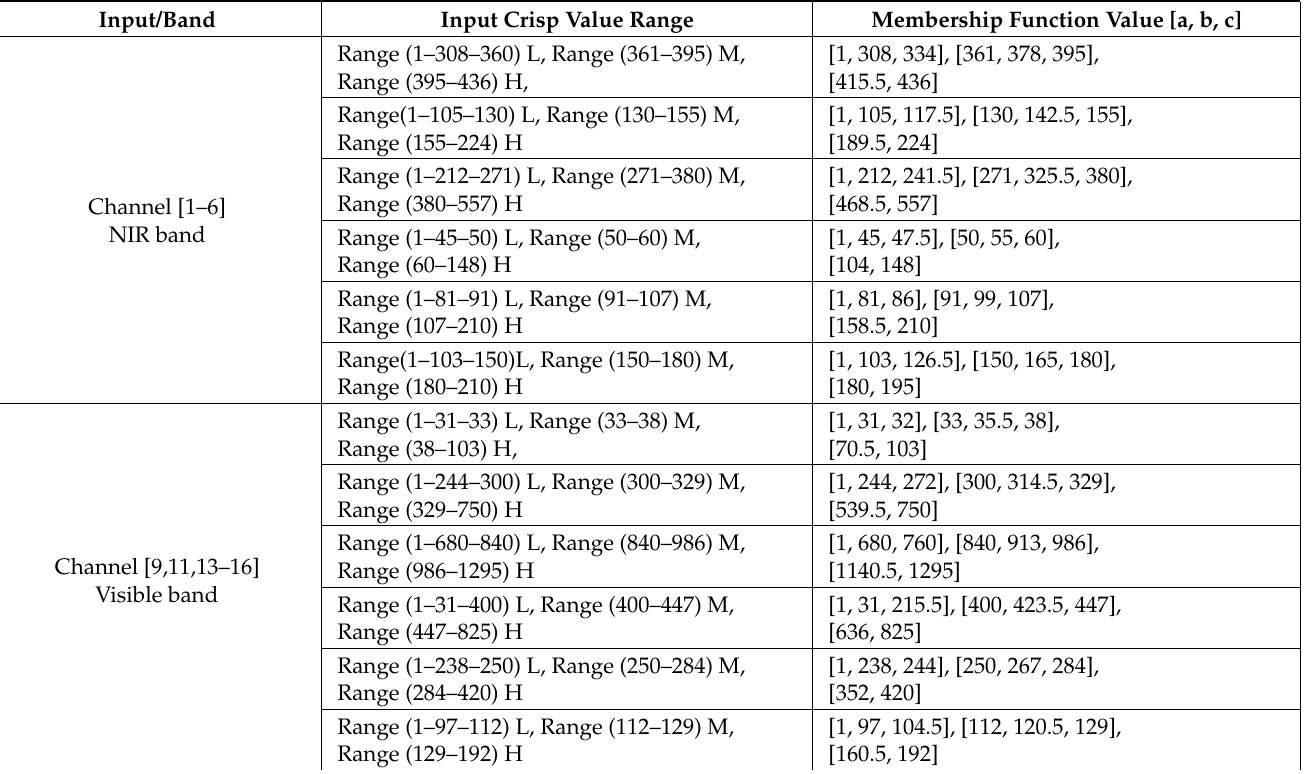
Table 2. Input triangle membership function a,b,c